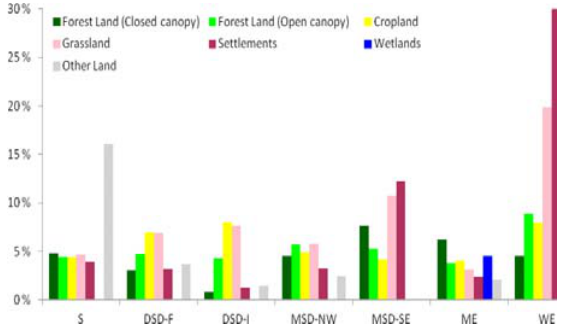
Figure 8. Proportional LiDAR Sampling Intensity per Land Use (LU) class.